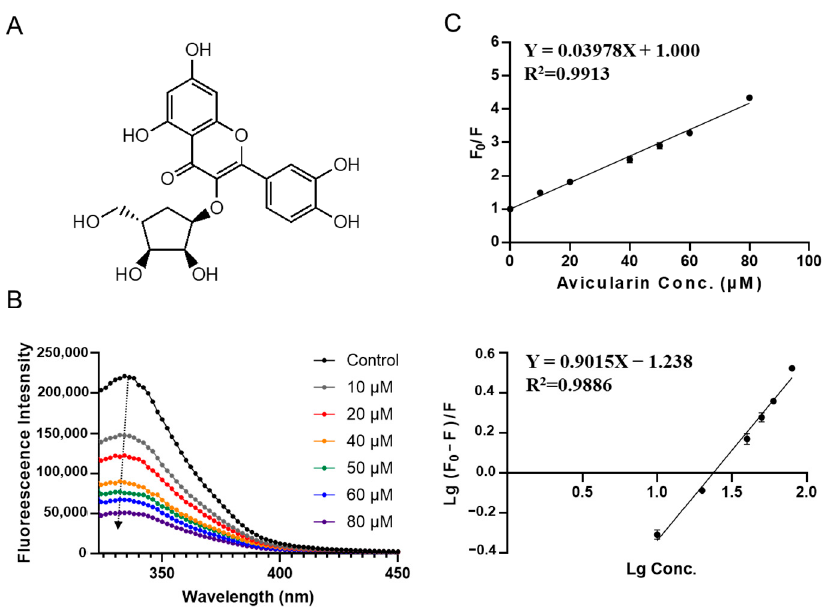
Figure 7. Fluorescence spectroscopy of SPI–avicularin interaction. ( A ) Molecular structure of avicu- larin and fluorescence spectra of SPI at different concentrations of avicularin (10, 20, 40, 50, 60, 80 µ M). ( B ) The Stern–Volmer curve chart. ( C ) The Stern-Volmer plots for binding parameter Table 2. Binding parameters of selected SPI–phytochemical compound interaction.